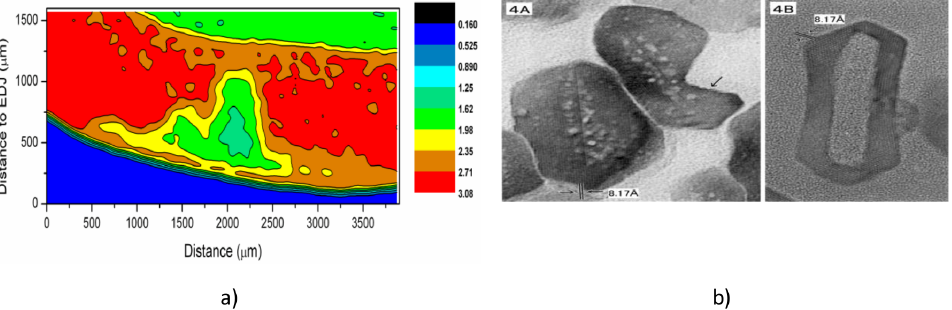
Figure 4. a) MicroCT image of mineral density of enamel proximal white spot lesion [47], and (b) TEM observations of the manner in which mineral is lost at the nanoscale [50].